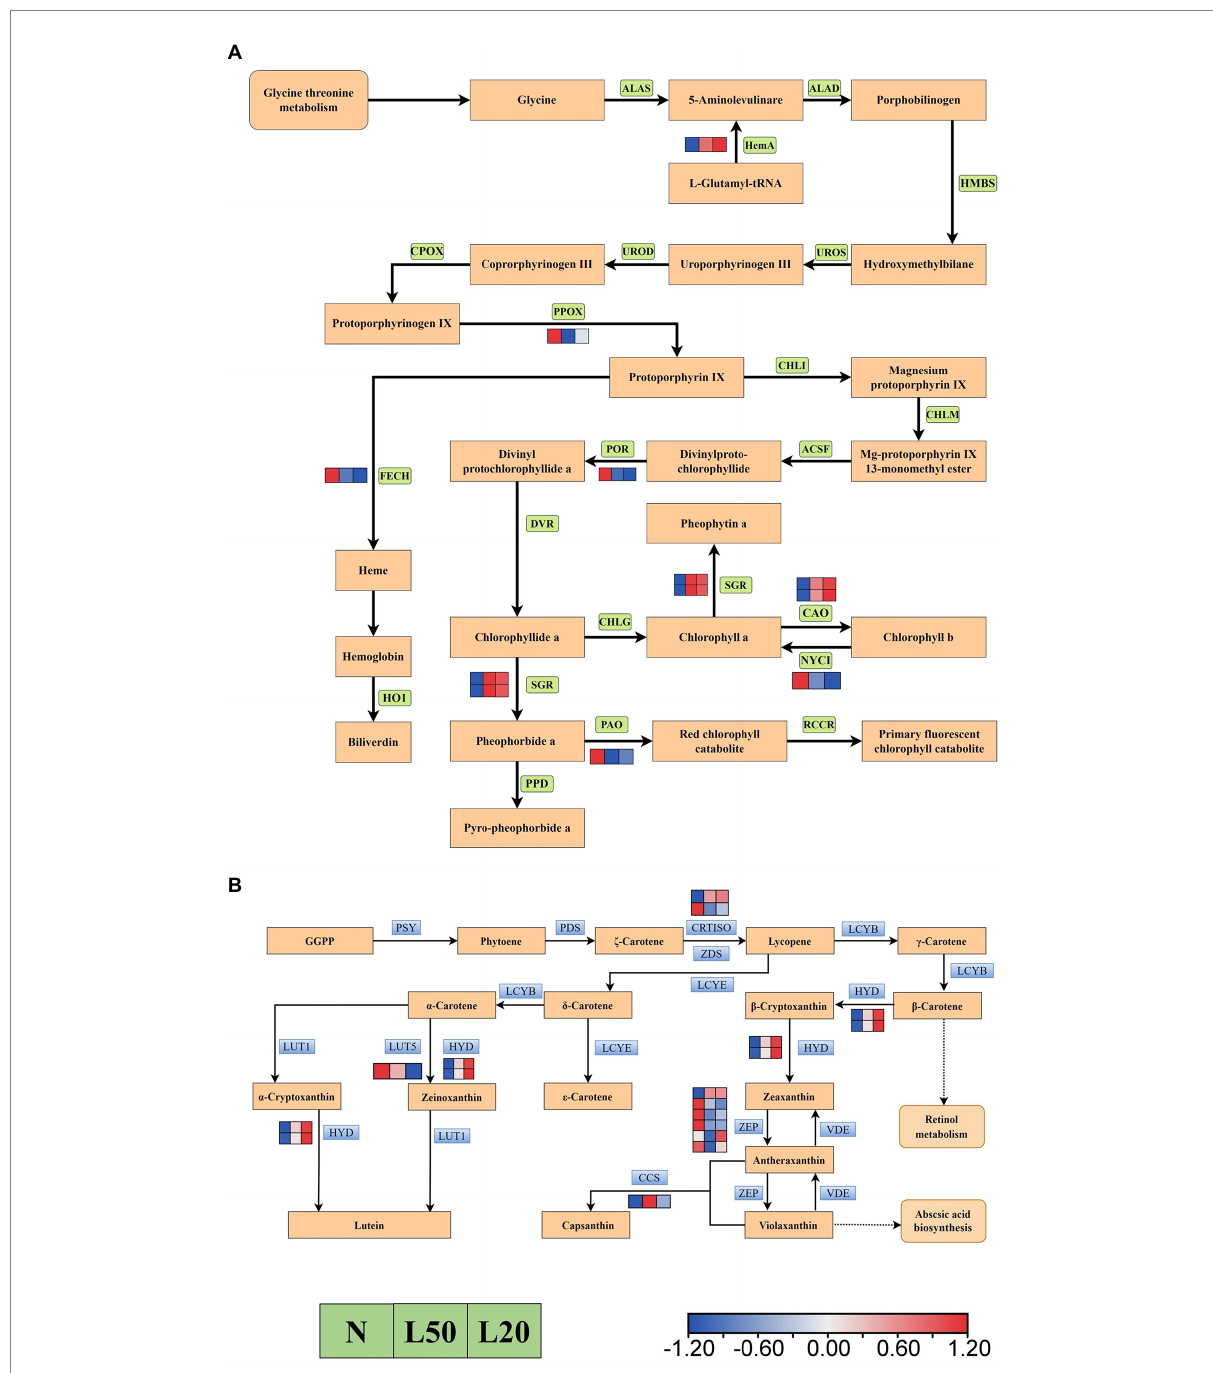
FIGURE 10 Transcriptional profiling of differentially expressed genes (DEGs) associated with pigment metabolism in J. mandshurica under shade. (A) The DEGs involved in chlorophyll metabolism. (B) The DEGs involved in carotenoid biosynthesis. The color scale from Min (blue) to Max (red) refers to the expression value from low to high. N: natural sunlight. L50: 50% sunlight to go through. L20: 20% sunlight to go through. (A) ALAS, 5-aminolevulinate synthase; HemA, glutamyl-tRNA reductase; ALAD, porphobilinogen synthase; HMBS, hydroxymethylbilane synthase; UROS, uroporphyrinogen-III synthase; UROD, uroporphyrinogen decarboxylase; CPOX, coproporphyrinogen III oxidase; PPOX, protoporphyrinogen/ coproporphyrinogen III oxidase; FECH, protoporphyrin/coproporphyrin ferrochelatase; HO1, heme oxygenase 1; CHLI, magnesium chelatase; CHLM, magnesium-protoporphyrin O-methyltransferase; ACSF, magnesium-protoporphyrin IX monomethyl ester (oxidative) cyclase; POR, protochlorophyllide reductase; DVR, divinyl chlorophyllide a 8-vinyl-reductase; CHLG, chlorophyll/bacteriochlorophyll a synthase; SGR, magnesium dechelatase; CAO, chlorophyllide a oxygenase; NYC1, chlorophyll(ide) b reductase; PAO, pheophorbide a oxygenase; PPD, pheophorbidase; RCCR, red chlorophyll catabolite reductase. (B) PSY, 15-cis-phytoene synthase; PDS, 15-cis-phytoene desaturase; CRTISO, prolycopene isomerase; ZDS, zeta-carotene desaturase; LCYB, lycopene beta-cyclase; HYD, beta-carotene 3-hydroxylase; ZEP, zeaxanthin epoxidase; VDE, violaxanthin de-epoxidase; CCS, capsanthin/capsorubin synthase; LCYE, lycopene epsilon-cyclase; LCYB, lycopene beta-cyclase; LUT5, beta-ring hydroxylase; LUT1, carotenoid epsilon